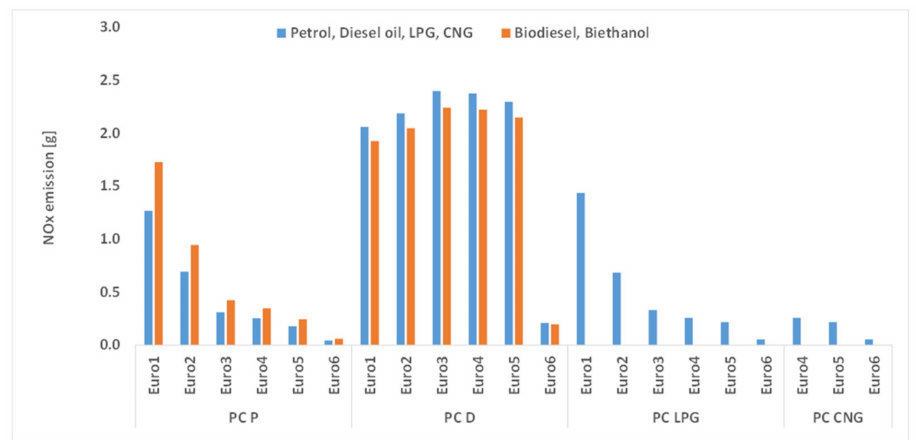
Figure 8. Comparison of NOx emissions from PCs depending on Euro standard and fuel type.